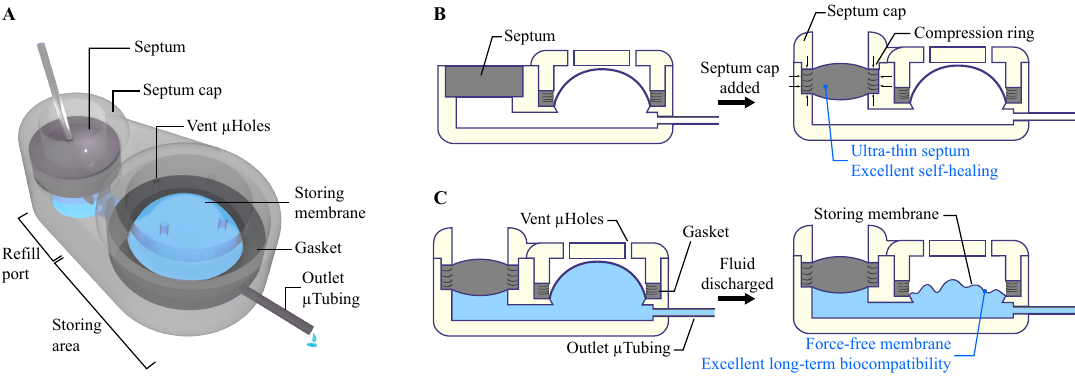
Figure 1. ( A ) Conceptual schematic of the microreservoir. The structure of the microreservoir is made of two main sections: the refill port for refilling the microreservoir by injections through a septum, and the storing area for drug storage. The structure is made with 3D-printing technology using a biocompatible resin, enabling printing micro-scale features that are readily scalable, allowing applications from mice to humans. ( B ) The septum cap incorporates a compression ring that causes the septum to be compressed both vertically and laterally. The vertical compression ensures sealing from the bottom and holds the septum during numerous injections. The lateral compression induces internal stress in the septum to improve its self-healing capability. This feature enables a significant reduction of the septum thickness while maintaining high resistance to leakage due to punctures. ( C ) The storing membrane is made of a pre-formed, dome-shaped, thin parylene-C layer, enabling zero forward flow and negligible backward flow after partial / full discharge of the microreservoir. When integrated to a pumping mechanism, this feature decouples the storing and pumping roles, which allows precise control over the flow rate. Finally, since all the components and coatings of internal and external surfaces are class VI biocompatible, long-term drug storage and minimal inflammation and infection for tissues in contact with the device are